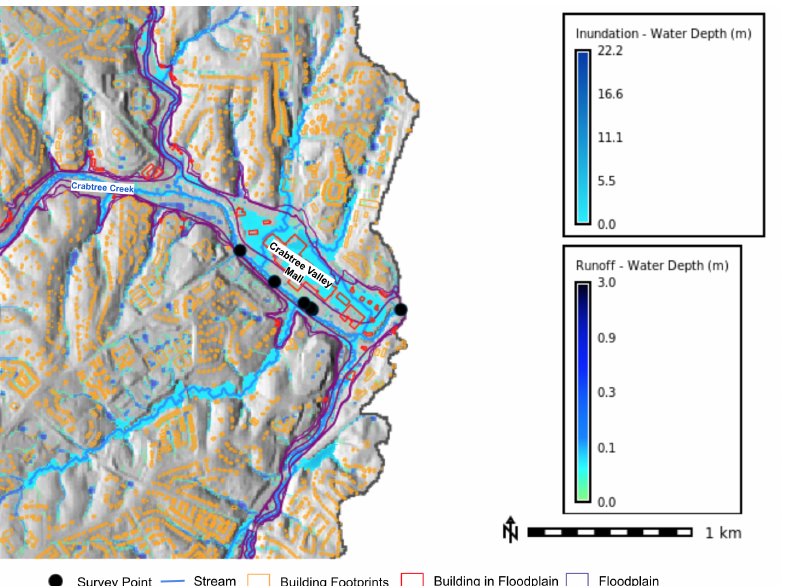
Figure 12. Cluster 2—During a simulated 100-year precipitation event, overland flow accumulated to depths up to 3m. One-meter maximum inundation extent shows that the location is prone to flooding.